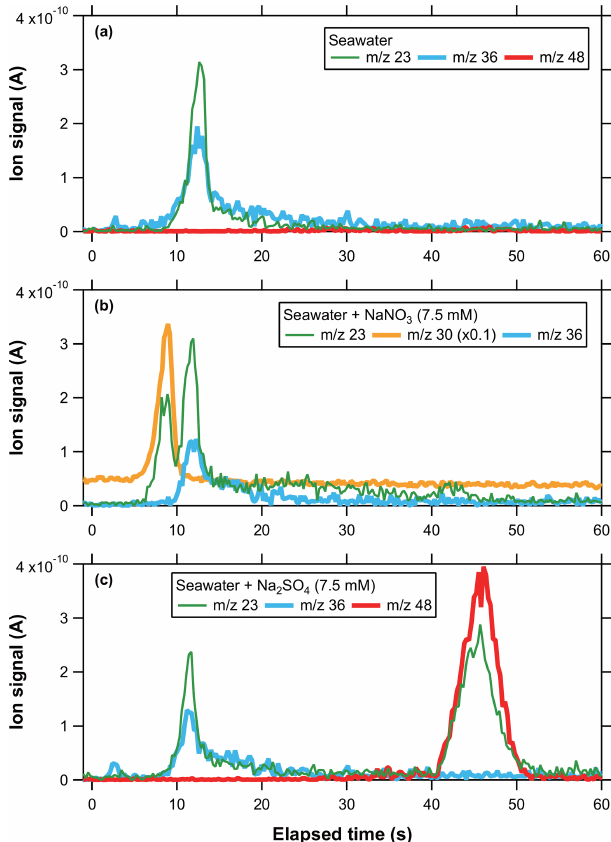
Figure 5. Temporal profiles of ion signals originating from (a) sea- water (equivalent to 4.5mM of SC), (b) seawater + SN (7.5mM), and (c) seawater + SS (7.5mM)